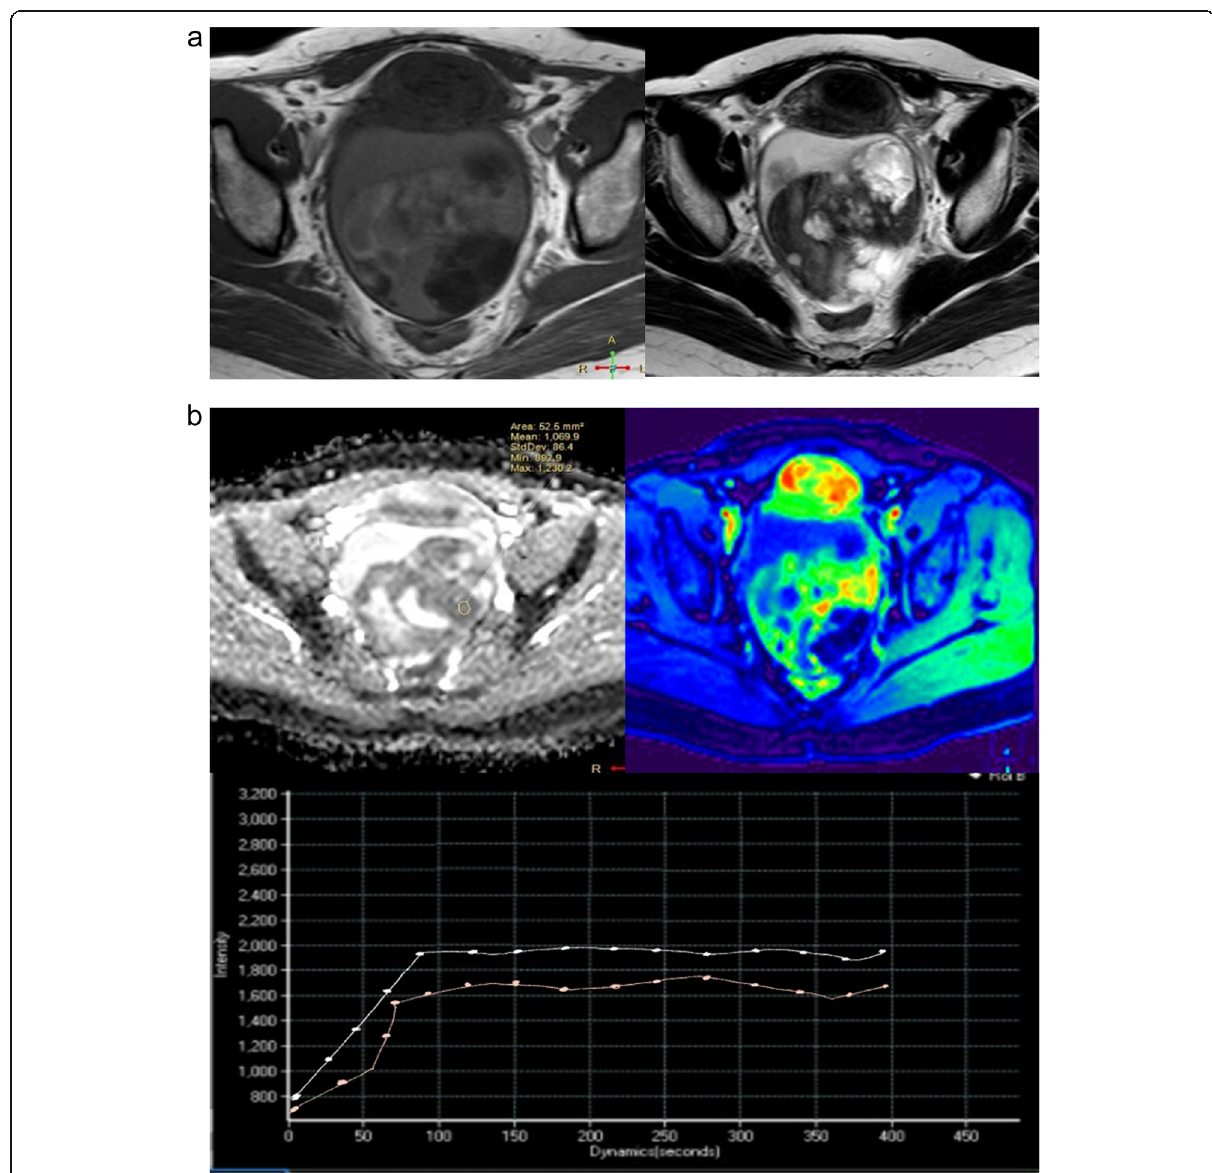
Fig. 2 A 28-year-old female presented with abdominal swelling. US revealed a large complex adnexal mass with thick septations and solid component. Axial T1 and T2 show a well-defined right adnexal lesion, dominantly cystic with thick septations and a small posterior